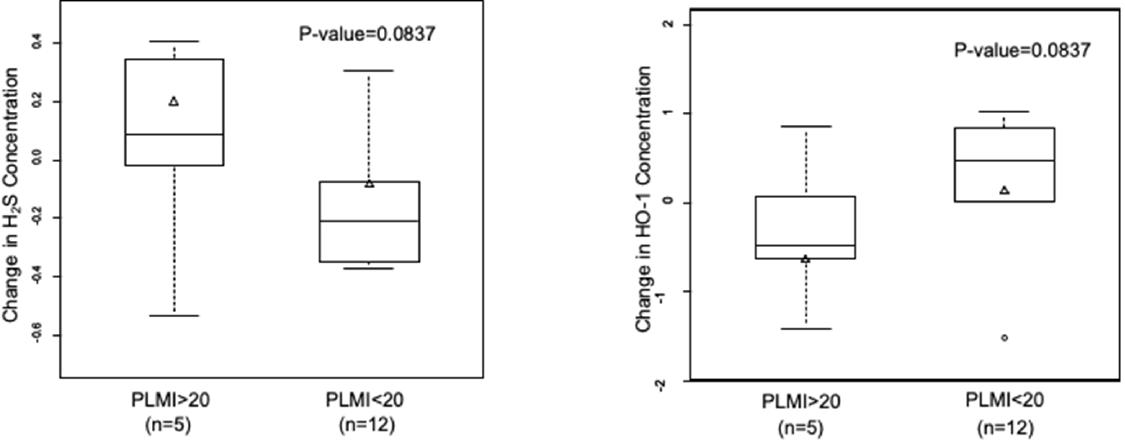
Figure 3. Inverse correlation in changes in H 2 S and HO-1 levels in relation to PLMI. Subjects with OSA diagnosis ( n = 17) were grouped based on PLMI. Data are shown as mean ± SE.